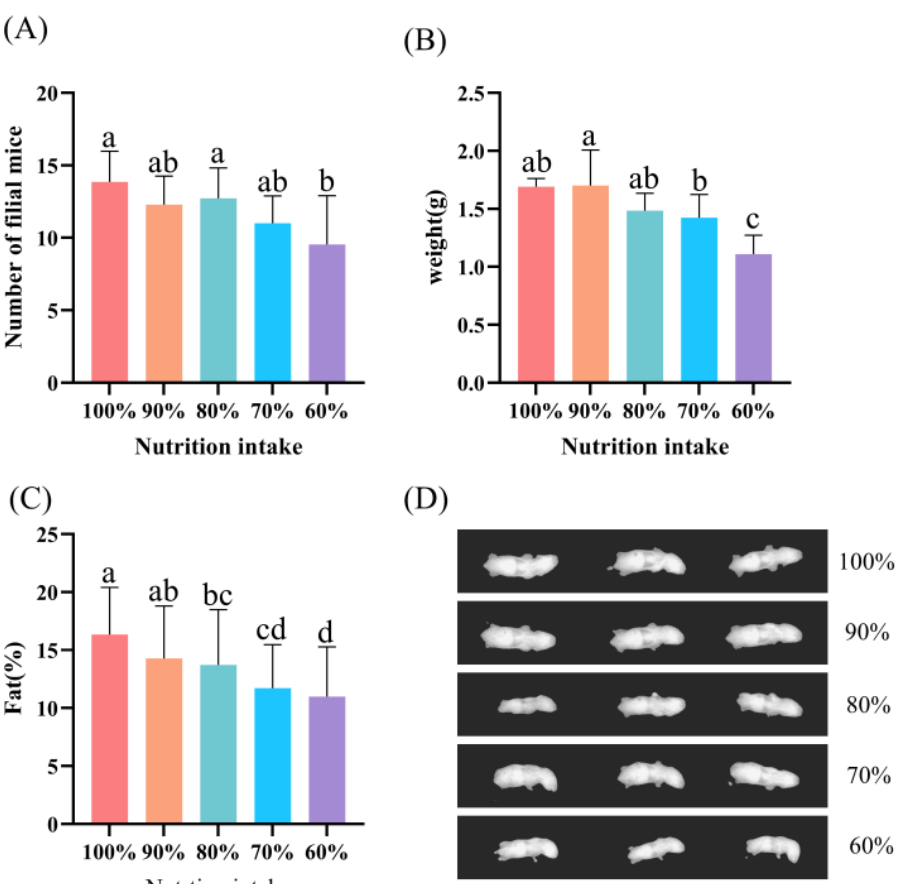
Figure 2. The number, body weight, body fat and X-ray images of maternally nutritionally restricted offspring. ( A ) Litter size in different nutrient-restricted groups. ( B ) Birth weight of offspring mice in different nutritionally restricted groups. ( C ) Body fat percentage of offspring mice in different nutrient restriction groups. ( D ) X-ray images of offspring mice in different nutritionally restricted groups. Identical letters are not significant difference ( p > 0.05), while different letters indicate significant difference ( p < 0.05), determined by one-way ANOVA followed by a Sidak multiple-com- parison test. Bar charts represent mean, error bars represent SD. Different colors represent different groups.